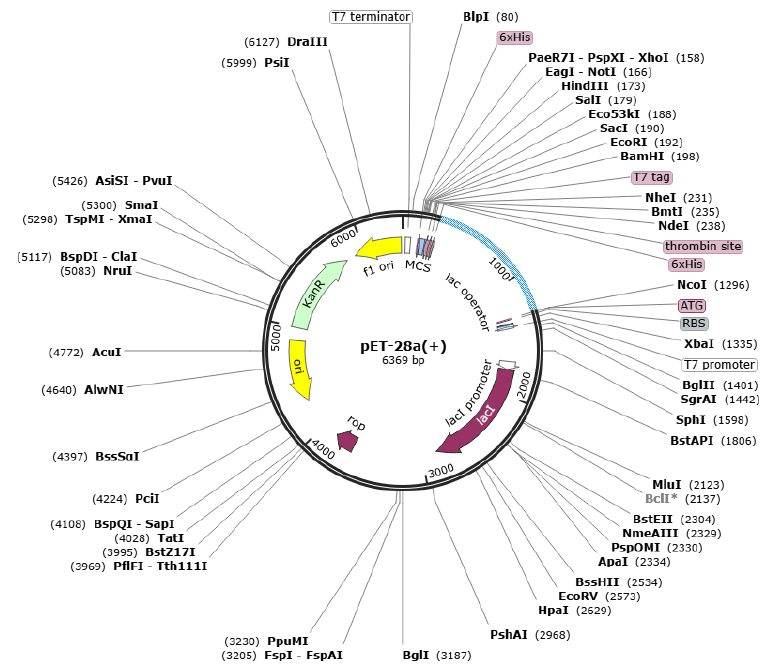
Figure 9. Vector with cloned vaccine. The vaccine is shown by sky blue color while the vector is in